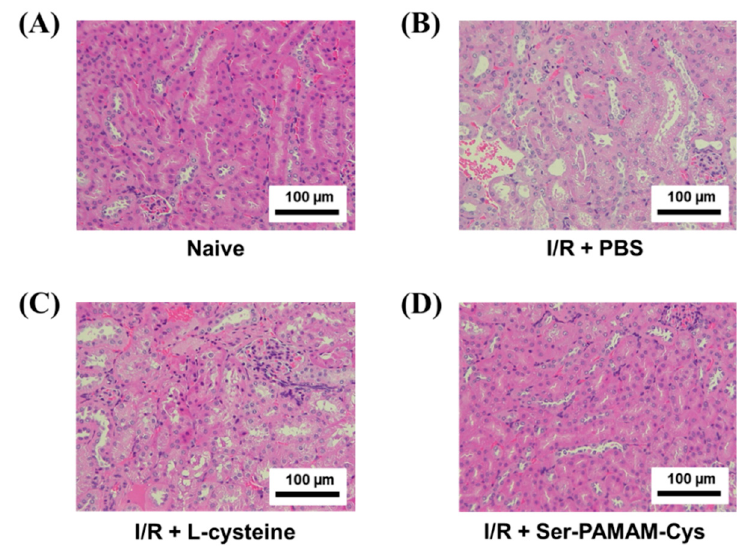
Figure 4. Effect of L-cysteine and Ser-PAMAM-Cys on changes in renal histology. Histological micrographs of sections from ( A ) naive and ischemia/reperfusion (I/R) mouse model kidneys after intravenous injection of ( B ) PBS, ( C ) L-cysteine, and ( D ) Ser-PAMAM-Cys. Scale bar: 100 µm.